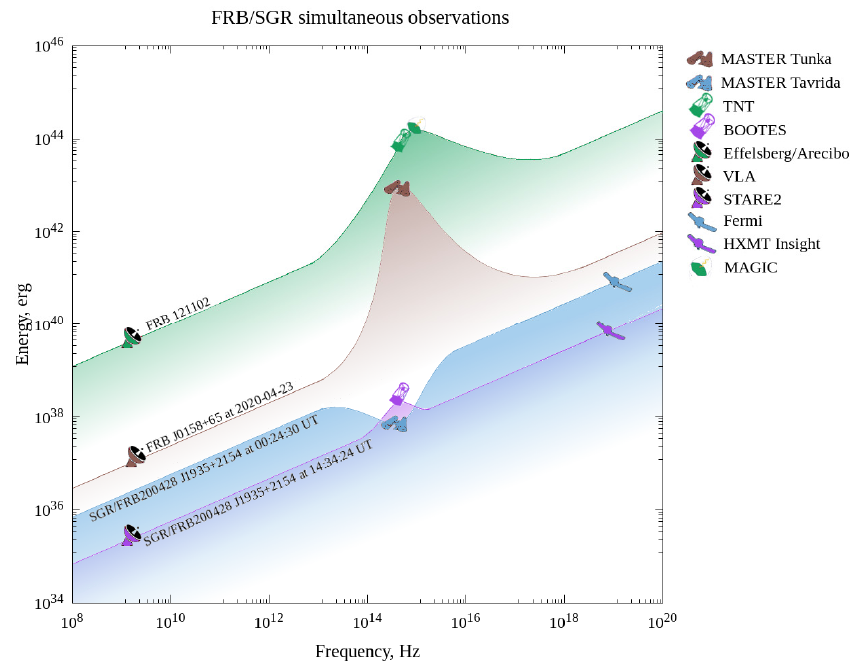
Figure 12. Results of simultaneous observations of fast radio burst sources for 28 April 2020 14:34:24 UT. The first X-ray detection of FRB synchronous with radio emission is shown in purple. Assuming a power-law spectrum, they set the slope on the entire graph α ≈ 0.46. The X-ray flare of SGR J1935+2154 at 00:24:30 UT on 28 April 2020 and our optical limit from MASTER-Tavrida are shown in blue.